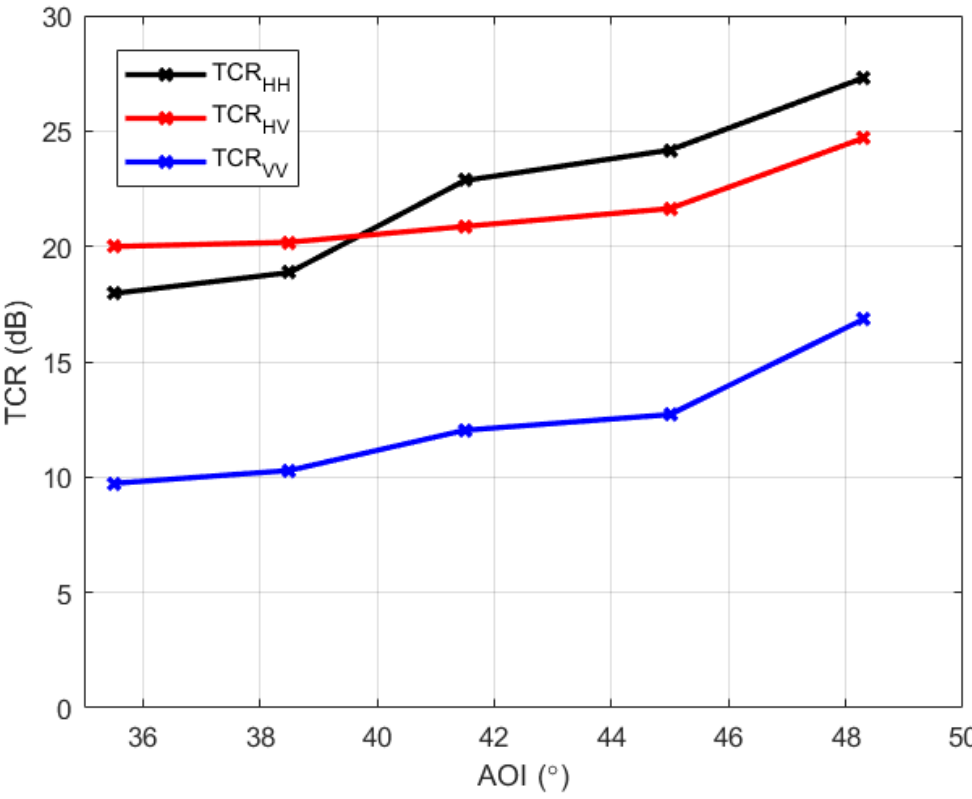
Figure 10. TCR versus AOI for different polarisations. Black, red, and blue plots refer to the HH-, HV-, and VV-polarised